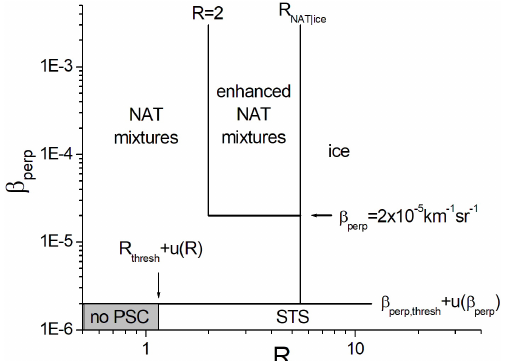
Figure 2. The figure shows the detection and classification criteria of the V2 CALIOP algorithm. The classification as STSs, NAT mix- tures, enhanced NAT mixtures and ice requires that threshold con- ditions for R and/or β ⊥ are satisfied. Please note that the thresholds are dynamic thresholds, except for the threshold on R that separates NAT mixtures from enhanced NAT mixtures. The figure has been adapted from Snels et al.